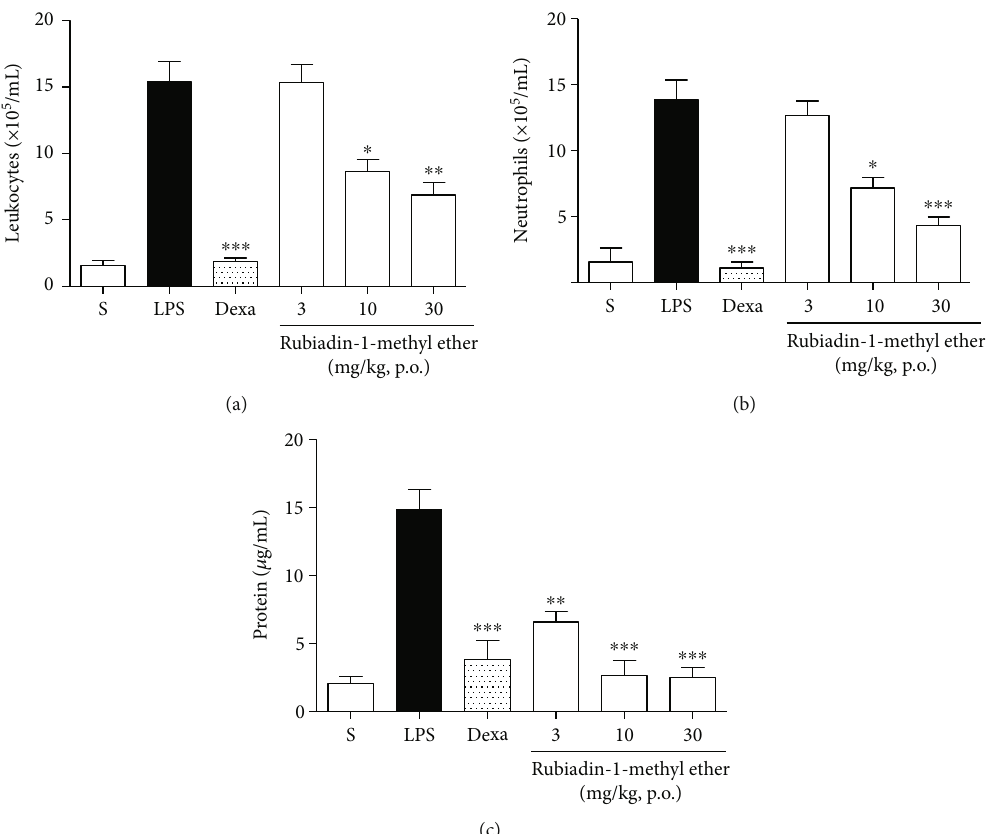
Figure 5: E ff ect of Rubiadin-1-methyl ether on total leukocyte counts (a), neutrophil counts (b), and exudation (c). S: healthy animals only treated with 0.9% sterile saline and vehicle (1% DMSO); LPS: (negative control) in fl amed animals only stimulated with LPS (1 μ g/mL) at intranasal route (i.n.); Dexa: (positive control) animals pretreated with Dexamethasone (5mg/kg, p.o.) 1h before LPS administration; Rubiadin-1-methyl ether: animals pretreated with Rubiadin-1-methyl ether at doses of 3, 10, and 30 mg/kg (p.o.) 1 h before LPS administration. The results were expressed as the mean ± S : D : ; n = 6 ; ∗ P < 0 : 05 , ∗∗ P < 0 : 01 , and ∗∗∗ P < 0 : 001 compared with the LPS